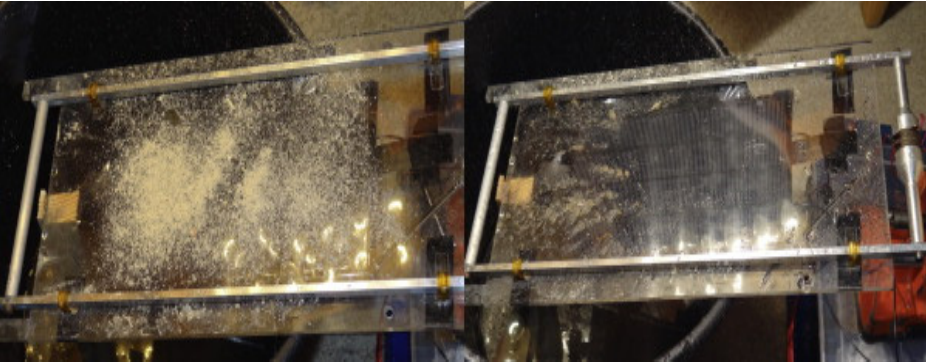
Figure 40. Uncleaned ( left ) panel and cleaned ( right ) PV panel after ultrasonic cleaning [161].